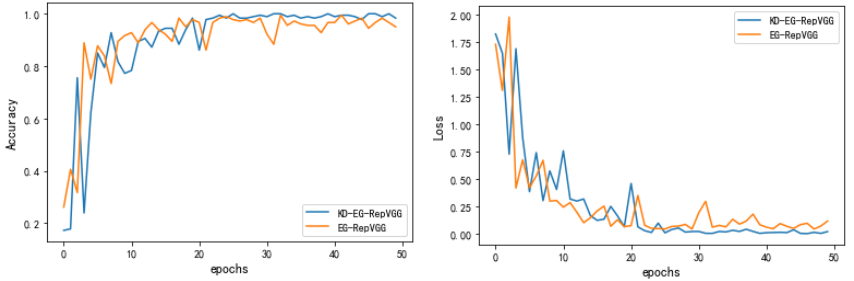
Figure 8. Validation set accuracy curves and loss curves.